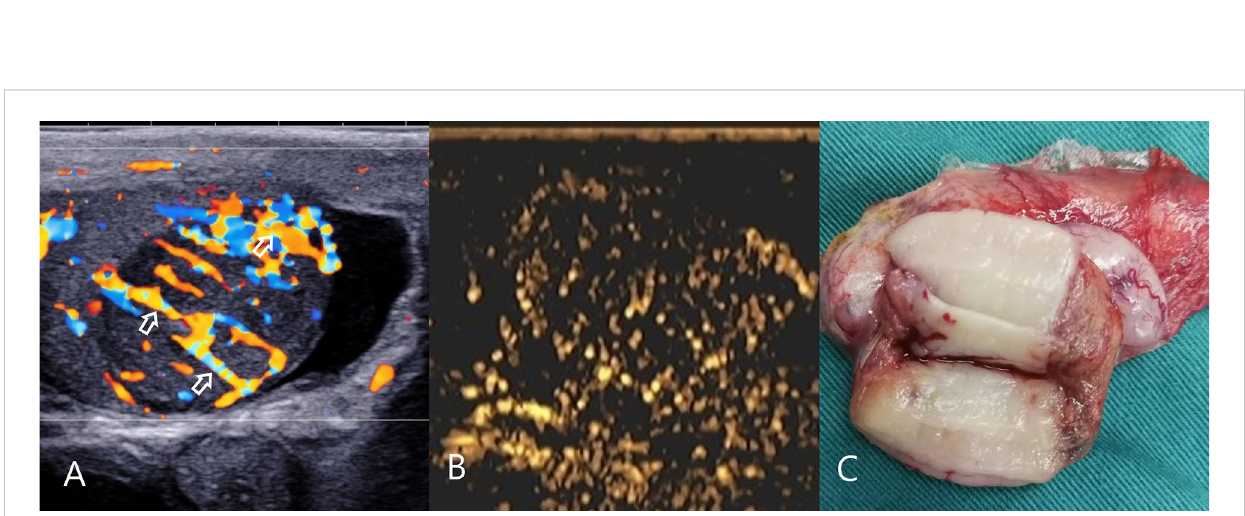
FIGURE 3 Testicular spermatocytic tumor. (A) CDFI: hypoechoic mass in the right testis, abundant blood fl ow and multiple perforating vessels(arrow), consistent with the ultrasound fi ndings of lymphoma. (B) CEUS: The CEUS showed heterogeneous sparse and low enhancement, which was signi fi cantly different from that of lymphoma. (C) Macro-section, Mass occupies most of the testicle; CDFI, Color Doppler Flow Imaging; CEUS, contrast-enhanced